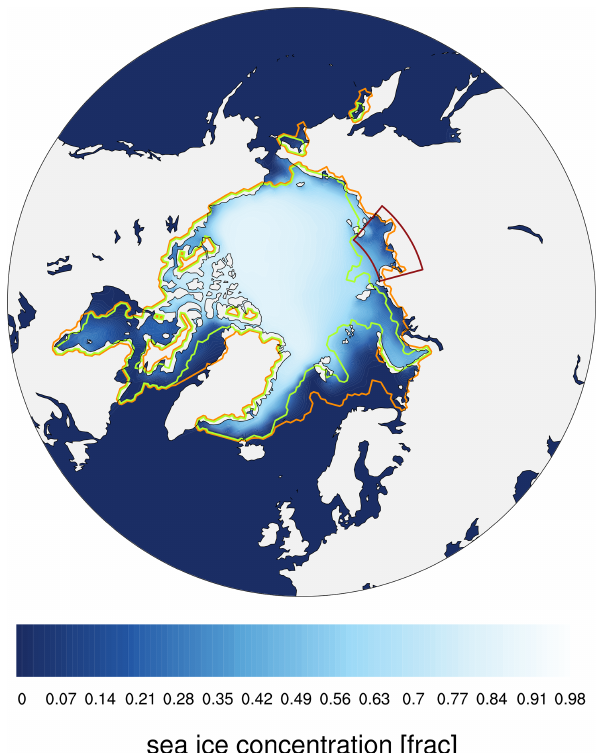
Figure 2. The July monthly-mean sea-ice concentrations are taken from the model described in the main text. The red box indicates Laptev Sea region and area over which one-dimensional time series of sea-ice cover are created. The contour lines show in green the minimum and in orange the maximum sea-ice cover. Note that all of the ocean in the red box might be either ice-covered or ice-free and that the Laptev Sea is one of the areas in the model with the highest variability in monthly July sea-ice